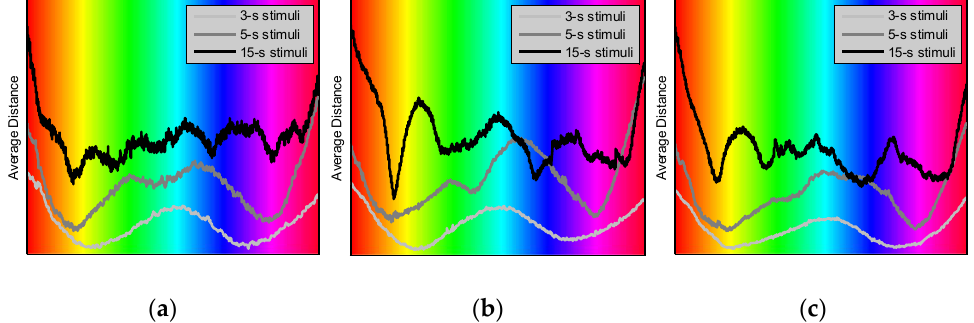
Figure 8. Average distance evaluated for the male participants and for Occipital ( a ), Parieto ‐ Temporal ( b ), and Frontal ( c ) EEG channels as a function of stimulation color.